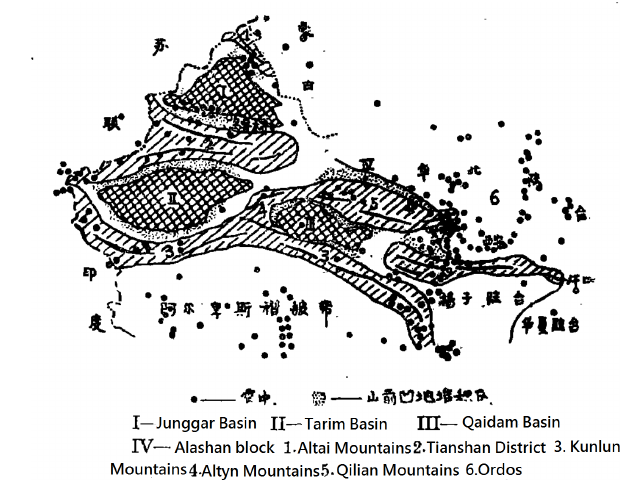
Figure 6. Map of earthquake intensity in China. (Source: Li, 1953.)